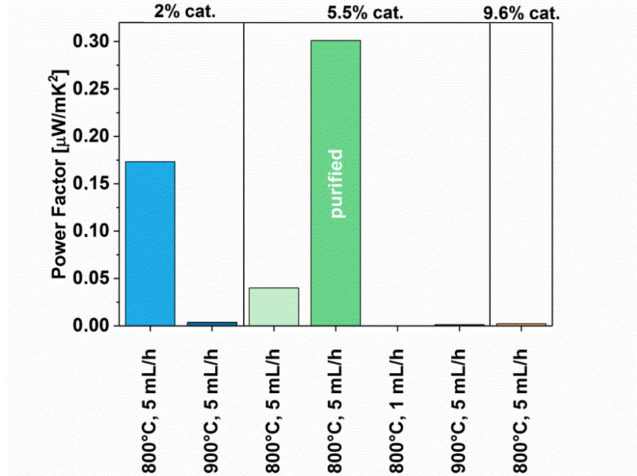
Figure 11. Power Factor of MWCNTs synthesized using di ff erent parameters (with and without